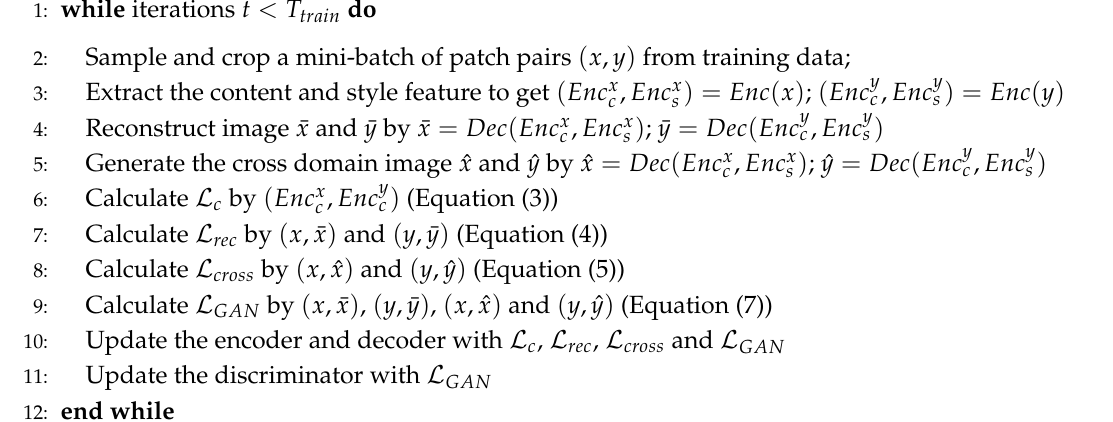
Algorithm 1 Training procedure of our proposed model.